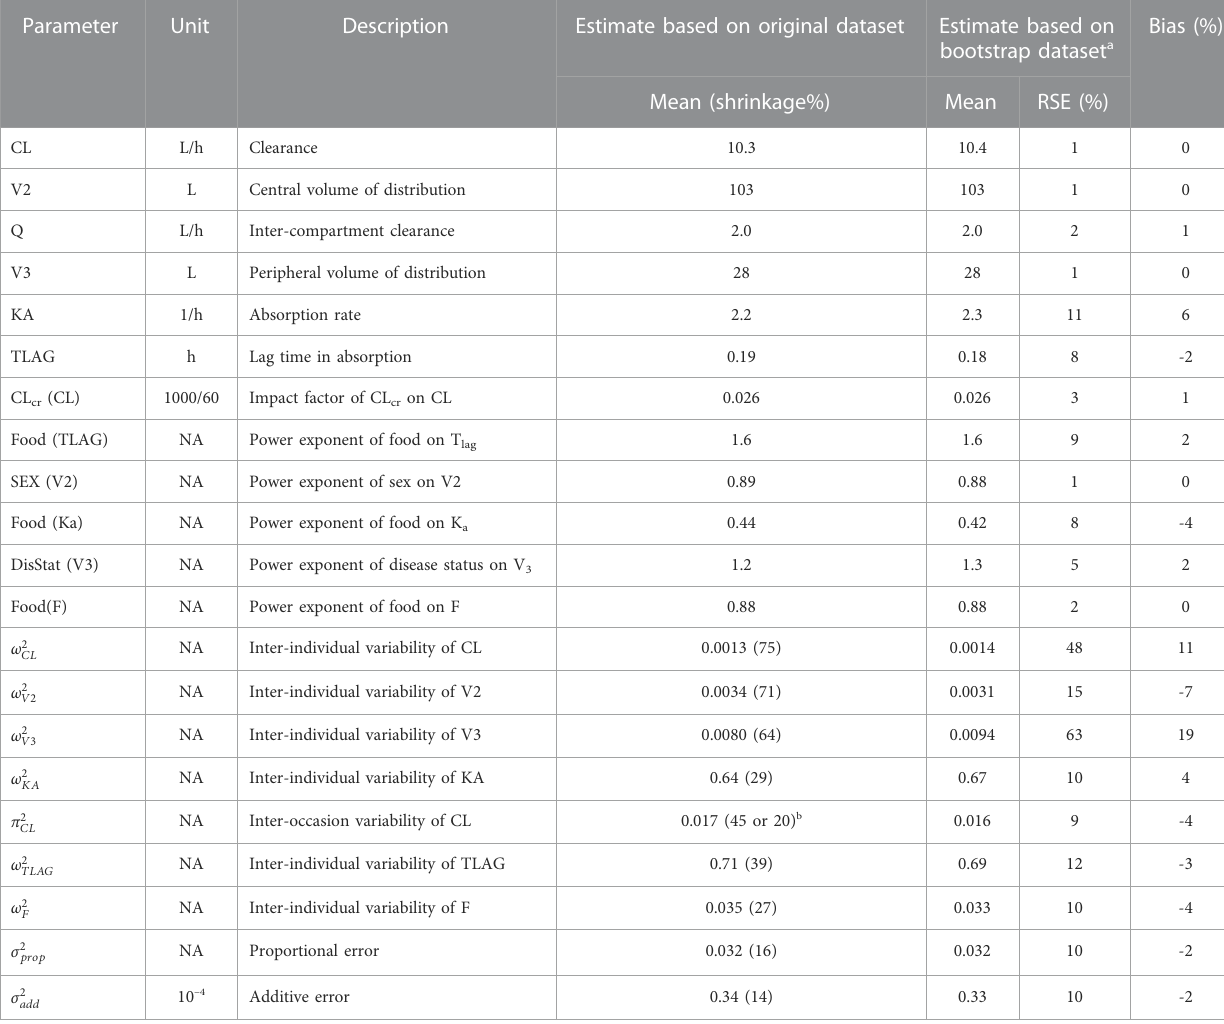
TABLE 2 Parameter estimates for fi nal population pharmacokinetic model of nemonoxacin. Parameter